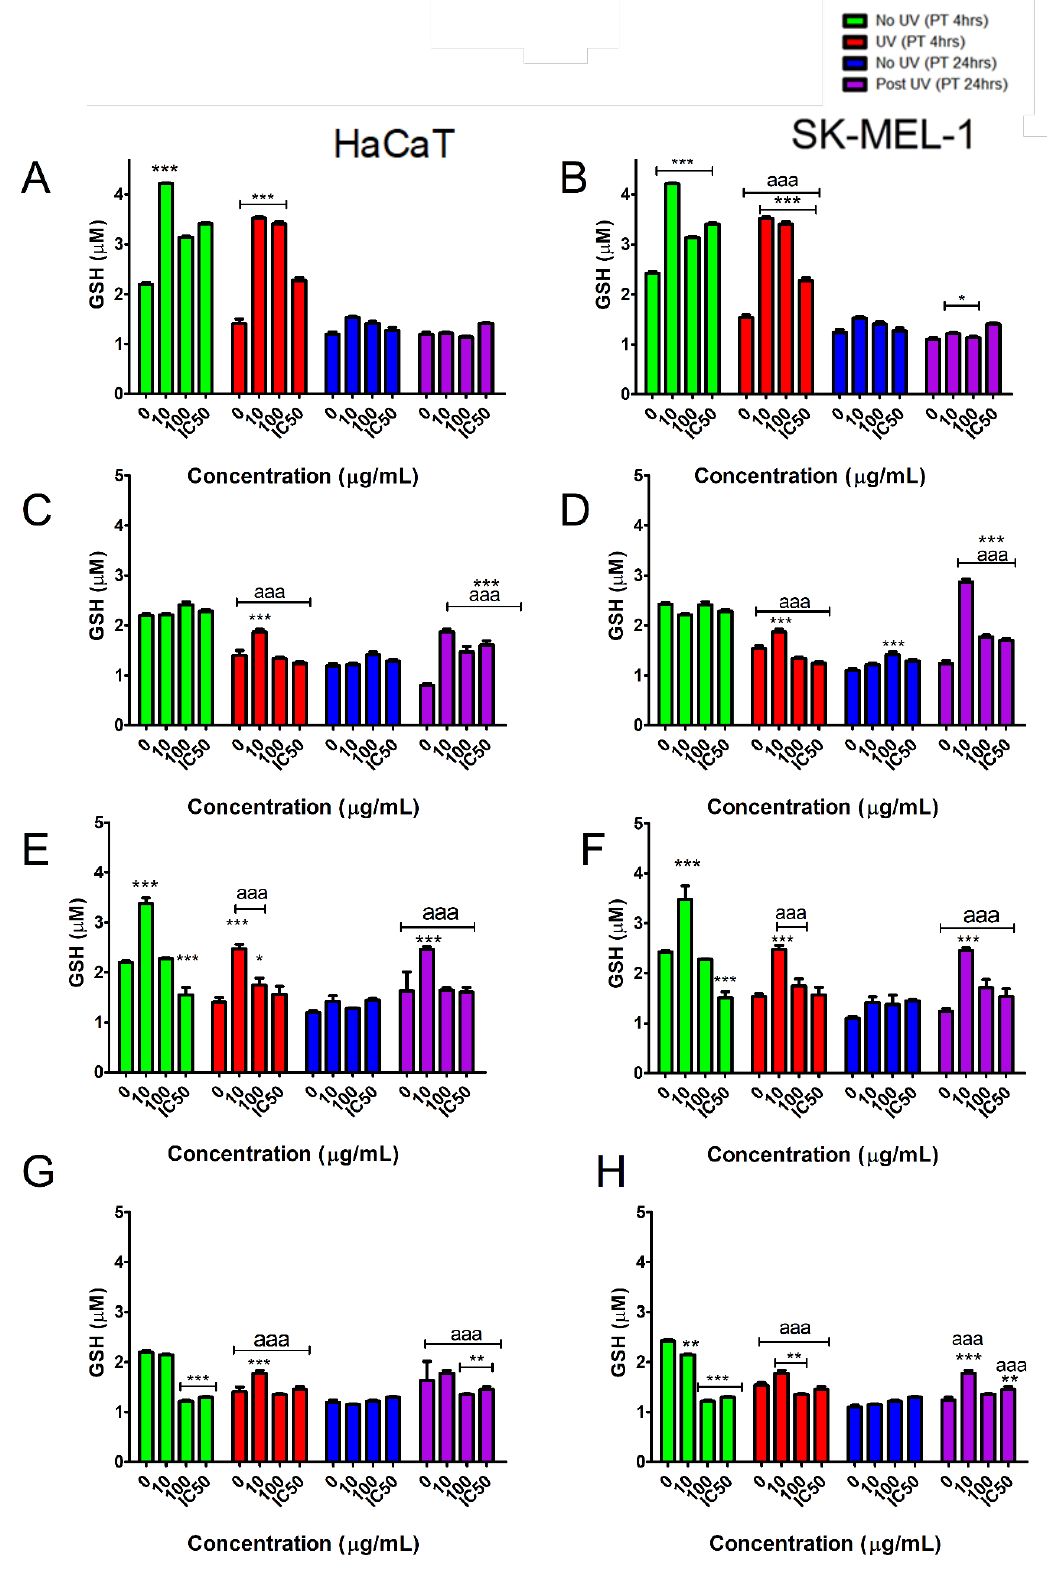
Figure 9. Effect of tested samples [TE ( A , B ); compound 1 ( C , D ); compound 2 ( E , F ); compound 3 ( G , H )] on glutathione (GSH) concentration in skin cells exposed to UVB irradiation. Vertical lines indicate standard deviation. * p < 0.05, ** p < 0.01, *** p < 0.001 control vs. experimental concentrations; aaa p < 0.001 No UVB irradiation vs. UVB irradiation for experimental concentrations.